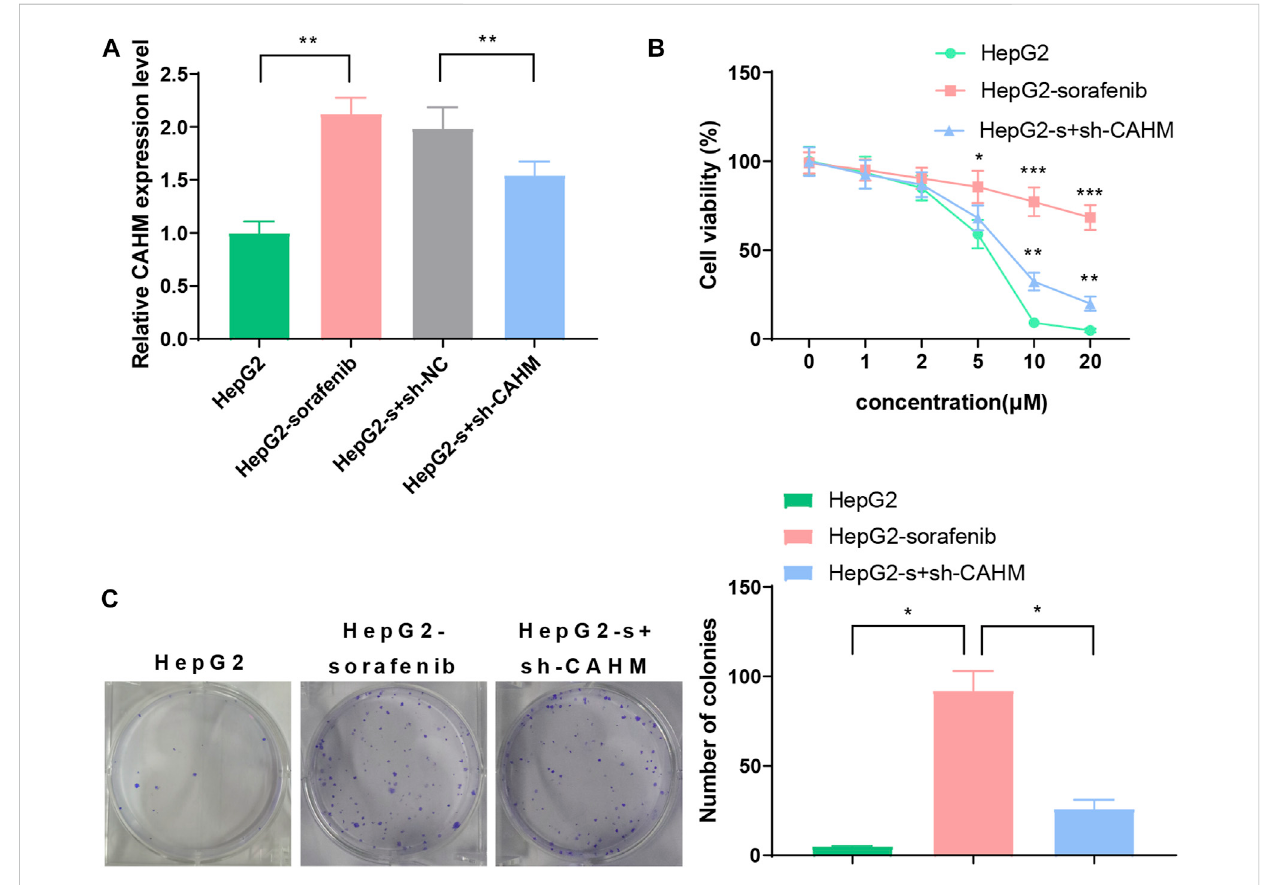
FIGURE 6 CAHM expression and cell proliferation (A) qRT-PCR validate CAHM expression in HepG2-sorafenib group was higher than that in the HepG2 group. (B) CCK8 assay show that the sensitivity of HepG2-sorafenib cells to sorafenib was signi fi cantly lower than that of HepG2 cells (C) Clonogenic assay demonstrate that the number of clones formed by sorafenib-treated HepG2-sorafenib cells was signi fi cantly higher than that of HepG2